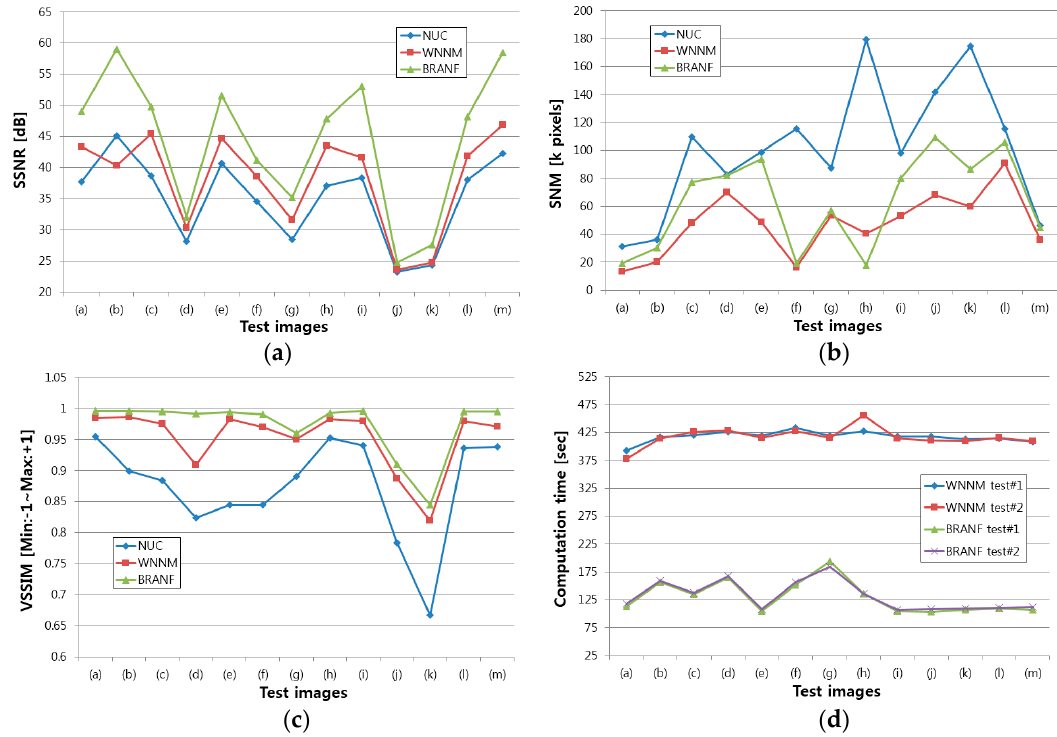
Figure 12. ( a ) SSNR value; ( b ) SNM value; ( c ) VSSIM value; ( d ) computation time of WNNM and BRANF.